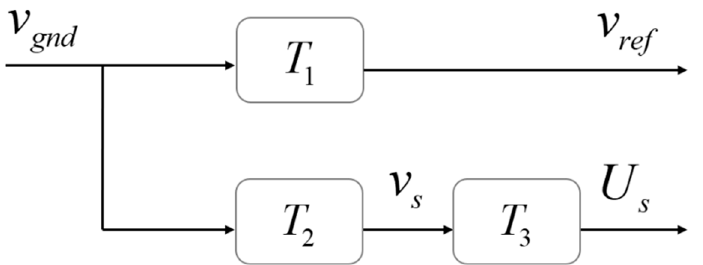
Figure 2. Relationship between a seismometer’s output and a Raman reflector’s vibration.